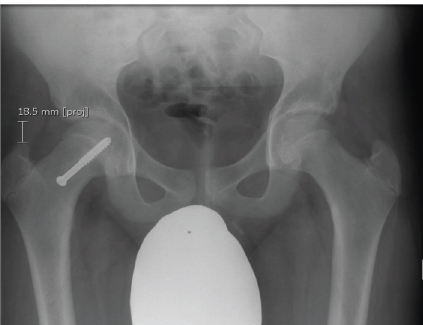
drawn from the top of the femoral head and extending laterally. The distance between the tip of the greater trochanter and this line is then measured. This measurement is used to assess for trochanteric overgrowth.